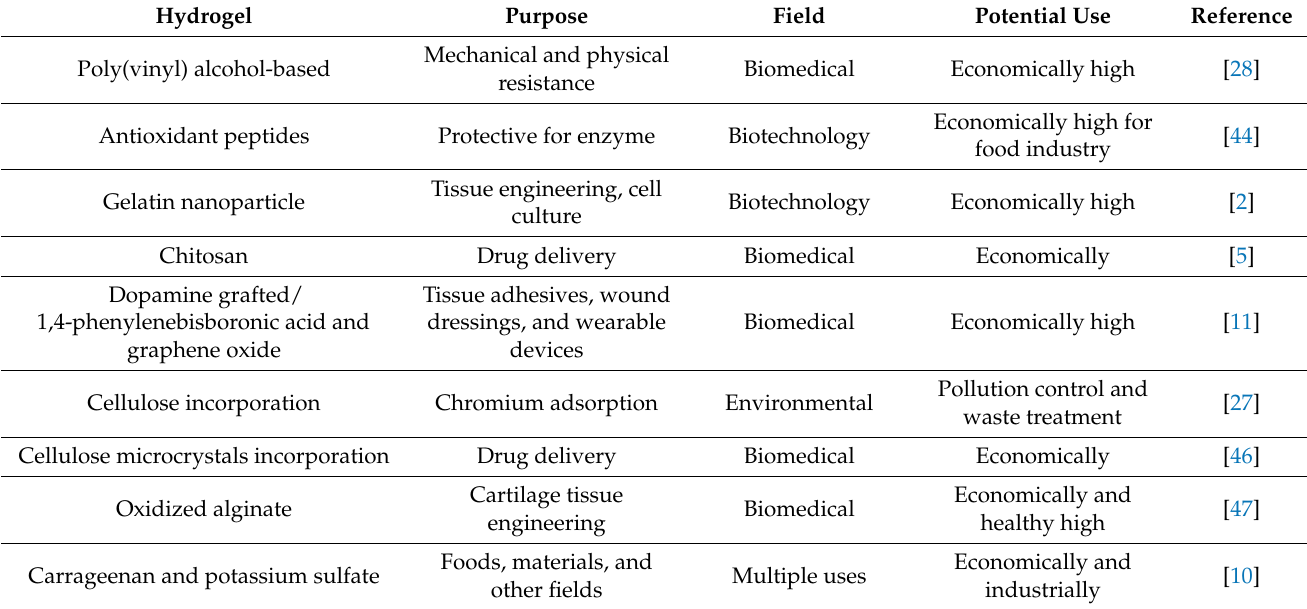
Table 1. Different purposes, applicability areas, and potential uses of gelatin-based